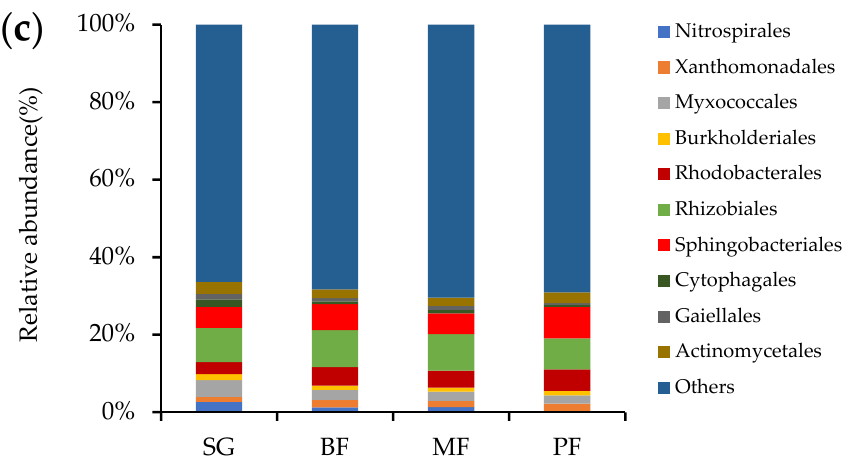
Figure 1. Distribution of bacterial communities in the different rehabilitation stages at different Phylum ( a ), Class ( b ), and Order ( c ) levels. SG: Shrub-grassland; BF: Broad-leaved; MF: Coniferous broad-leaved; PF: Primary forest.